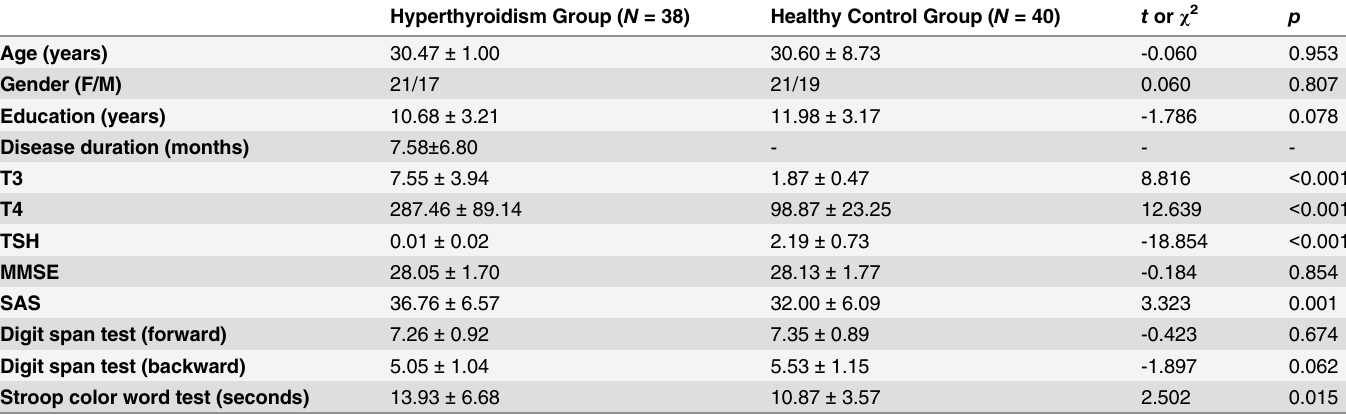
Table 1. Demographic and background data of the hyperthyroidism group and healthy control